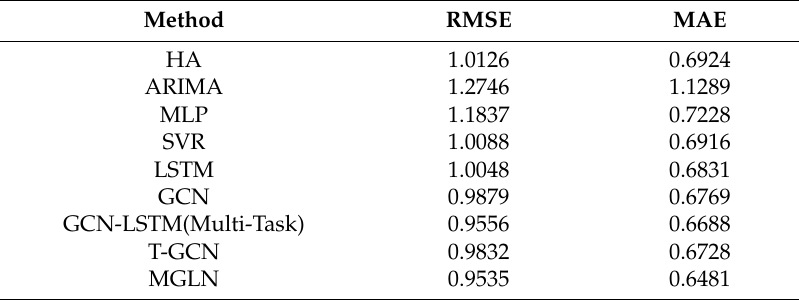
Table 2. Model Comparison